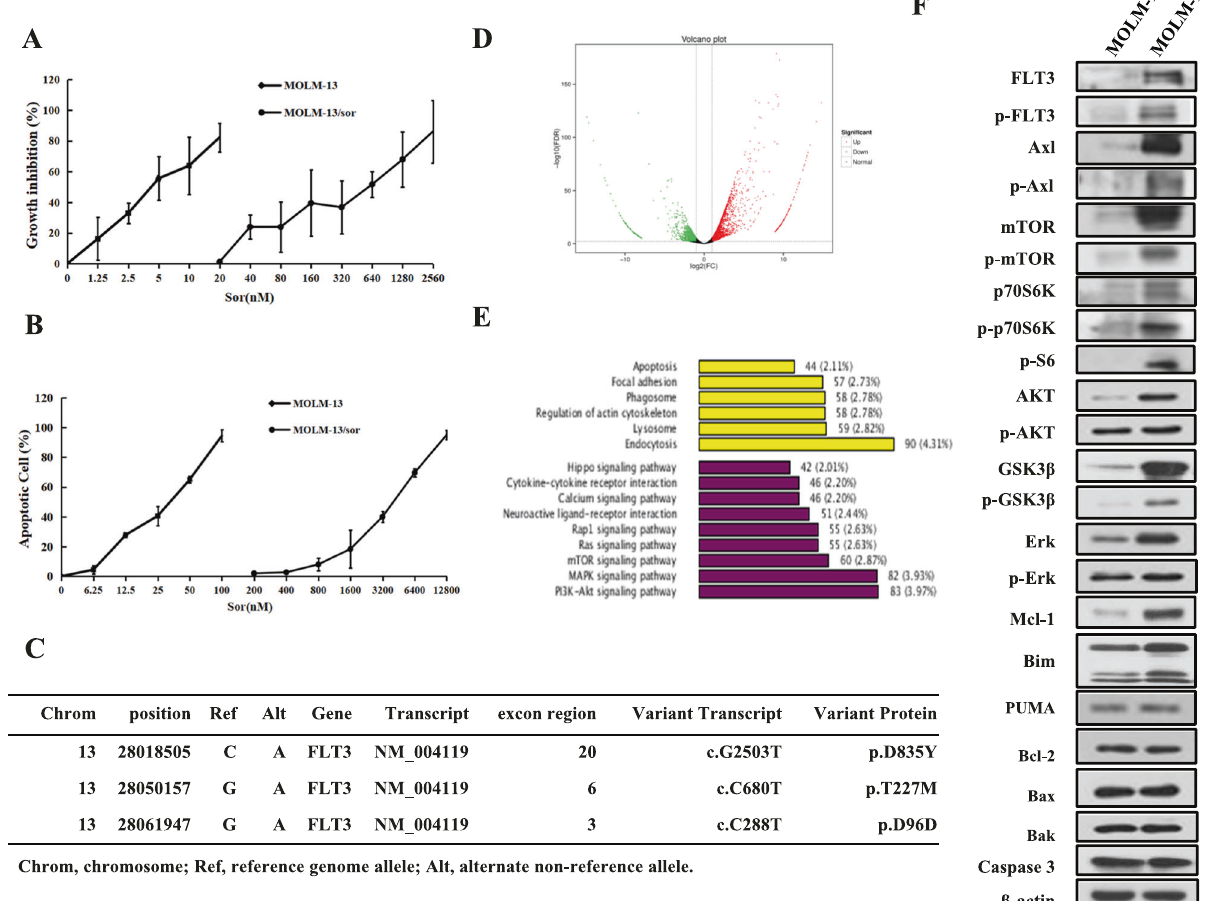
Fig. 3 Differentially expressed genes and proteins of MOLM-13 and MOLM-13/sor cells. A Growth inhibition rate of MOLM-13 and MOLM- 13/sor cells treated with sorafenib for 72 h. B Apoptosis of MOLM-13 and MOLM-13/sor cells treated with sorafenib for 24 h as detected by AO- EB staining. C WES analysis showing FLT3 mutations in MOLM-13/sor cells. D Volcano plot of the differentially expressed genes in MOLM-13/ sor cells compared to MOLM-13 cells. The green and red dots represent upregulated and downregulated genes, respectively. E KEGG classi fi cation of differentially expressed genes. The ordinate shows the KEGG pathway and the abscissa shows the number of genes under this pathway and its proportion in the total number of genes. F Differentially expressed proteins analyzed by Western blot analysis in MOLM-13 and MOLM-13/sor